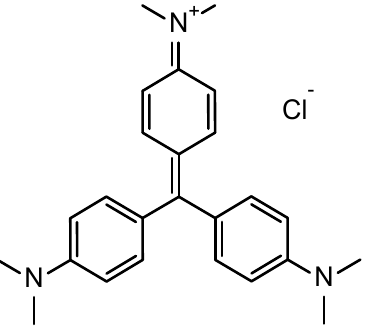
Figure 1. Chemical structure of cationic dye crystal violet (CV).